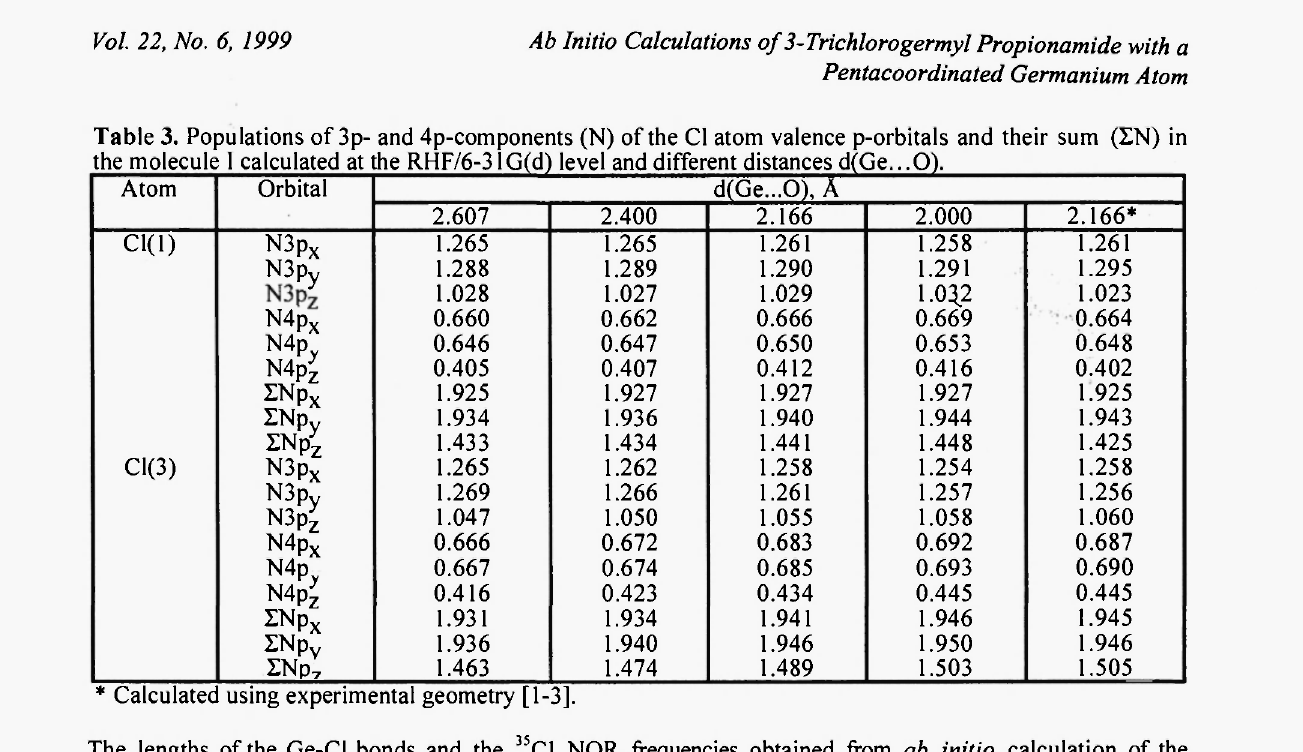
Table 4. jS Cl NQR frequencies (v) and asymmetry parameters (η) of the EFG at the j5 Cl nuclei in